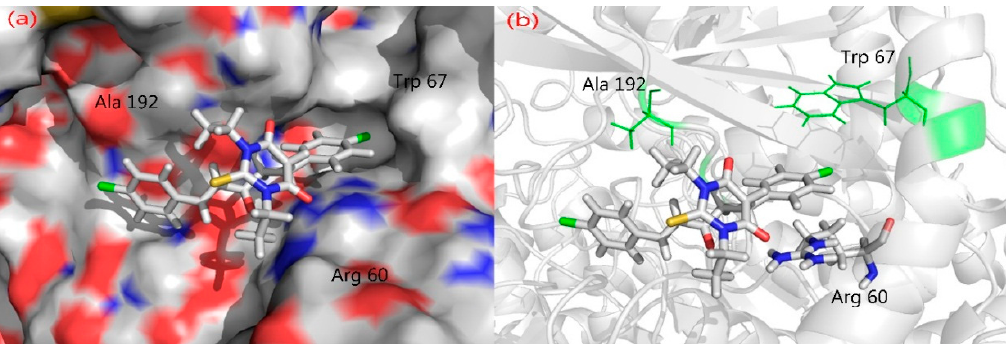
Figure 7. ( a ) Compound 3c fits to the active site cavity of GPb enzyme; ( b ) Binding conformation of compound 3c in the active site of GPb enzyme.